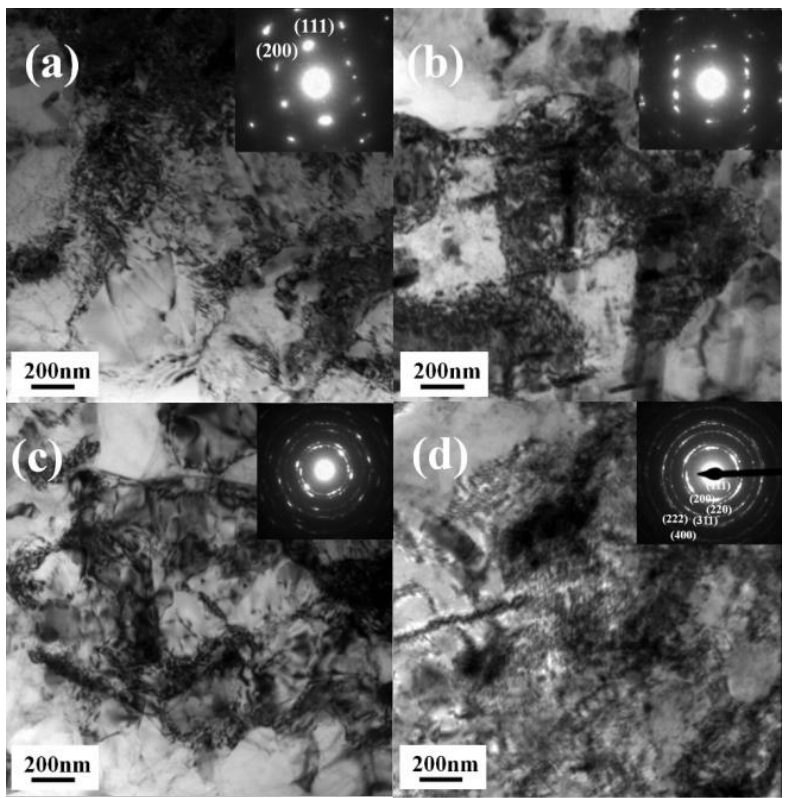
Figure 4. TEM images of the hot-rolled state 2524 alloy after cold rolling: ( a ) 10%; ( b ) 40%; ( c ) 80%; ( d ) 90%. ( d )